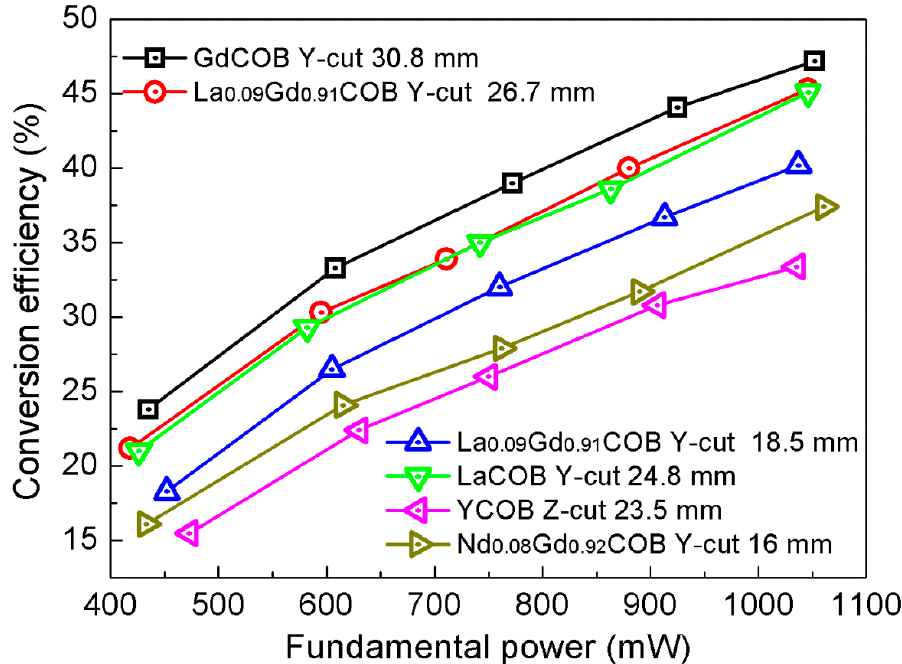
Figure 6. Type-I A-NCPM SHG conversion efficiency of RE1 x RE2 1 − x COB crystals for the Ti:sapphire